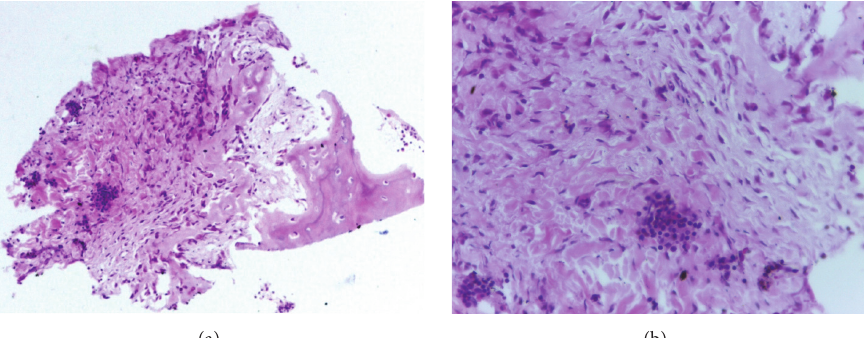
Figure 5: Histological study. (a) Periosteal reaction with inflammatory grouped lymphocytes infiltrate. (b) Detail of the fibroblastic periosteal proliferation with osteoid formation and lymphocytic